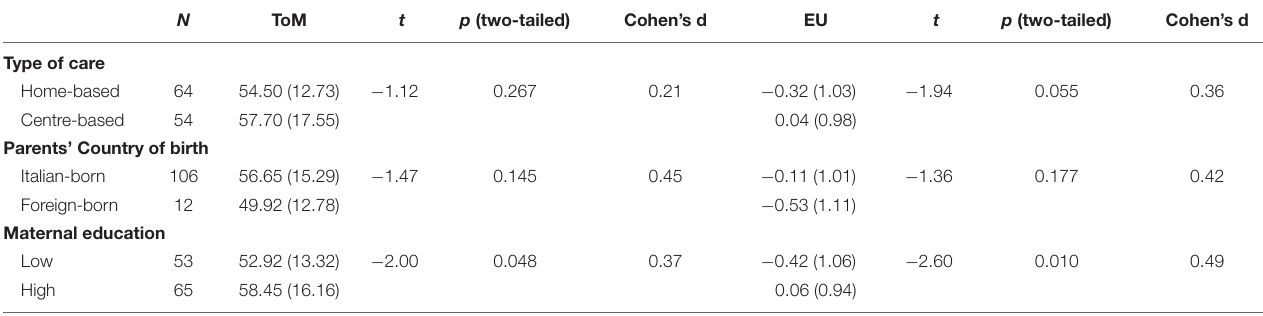
TABLE 2 | Differences by type of care, parents’ country of origin and maternal education between groups in relation to ToM and EU average scores (SD). N